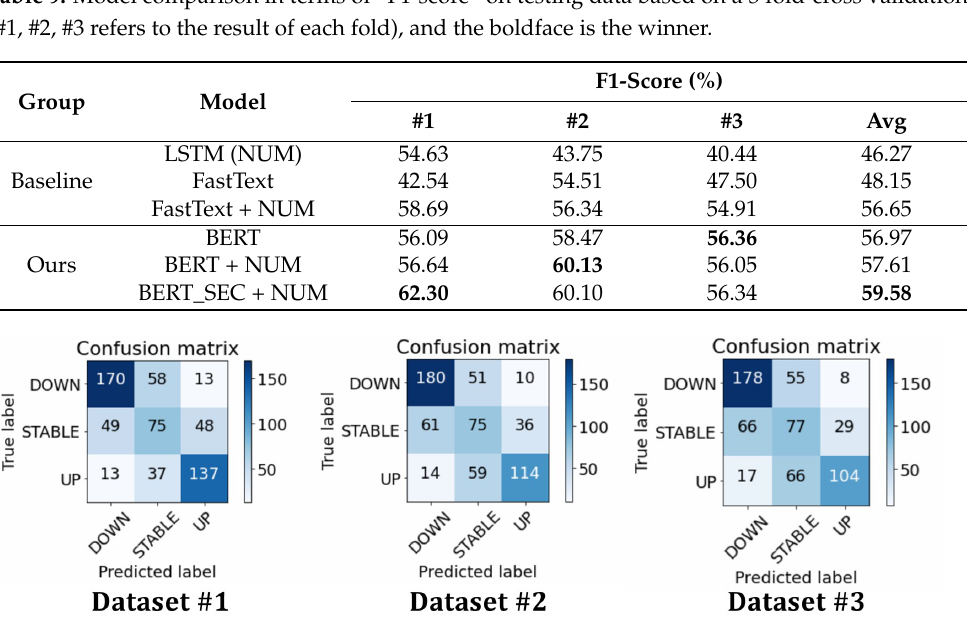
Figure 5. Confusion matrix of our sector-based model (BERT + NUM) on three